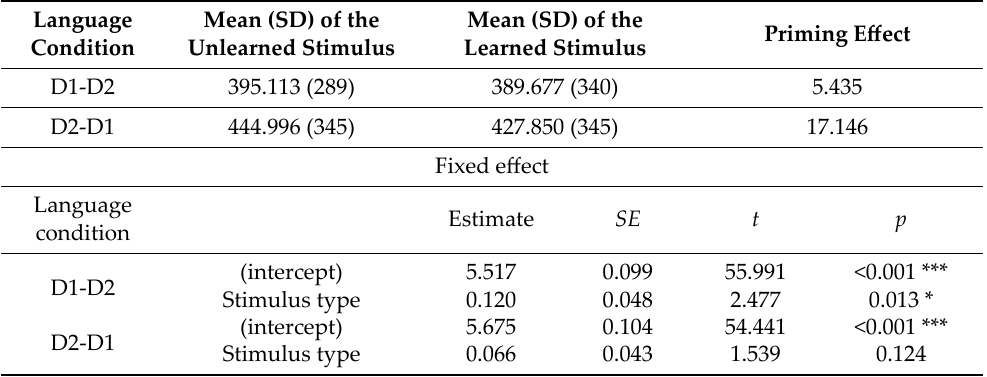
Table 2. Reaction times and the mixed‑effects modeling results for experiment